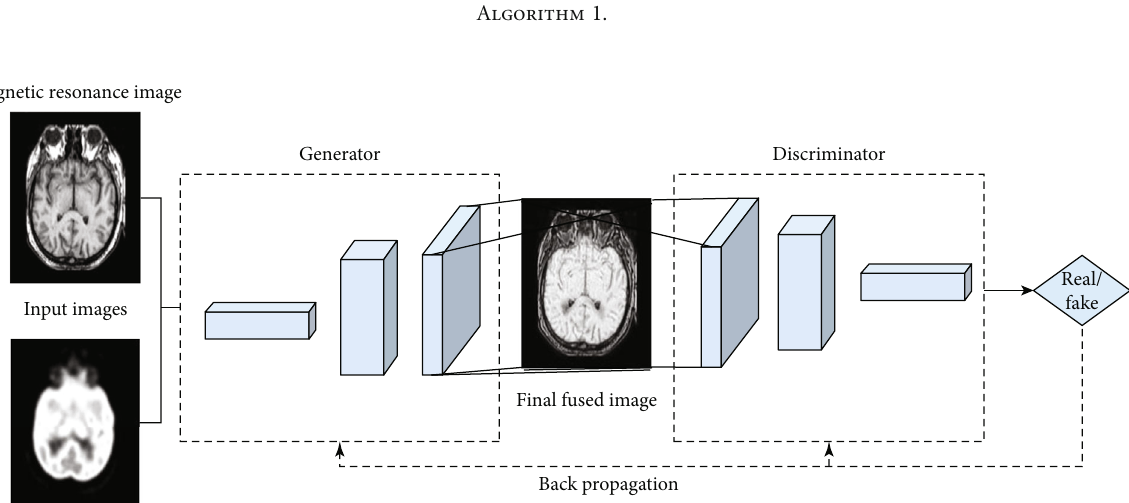
Figure 3: Architecture of the proposed approach for image